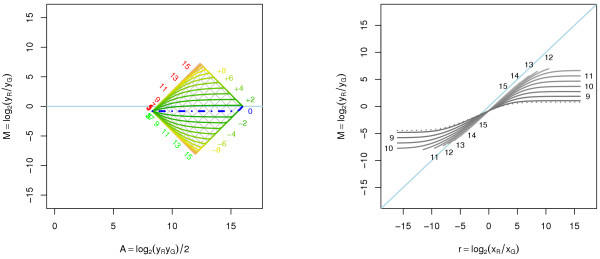
Parallel translation normalization of affine transformed data. Parallel translation normalization of A1
 MathType@MTEF@5@5@+=feaafiart1ev1aaatCvAUfeBSjuyZL2yd9gzLbvyNv2CaerbwvMCKfMBHbqedmvETj2BSbWenfgDOvwBHrxAJfwnHbqeg0uy0HwzTfgDPnwy1aqee0evGueE0jxyaibaieYdOi=BH8vipeYdI8qiW7rqqrFfpeea0xe9Lq=Jc9vqaqpepm0xbbG8FasPYRqj0=yi0lXdbba9pGe9qqFf0dXdHuk9fr=xfr=xfrpiWZqaaeaabiGaaiaacaqabeaadaqacqaaaOqaaGWaaiab=bq8bnaaBaaaleaatCvAUfKttLearCWrP9MDH5MBPbIqV92AaGqbaiab+fdaXaqabaaaaa@43C0@ transformed data. The optimal amount of normalization shift in the raw data is a = 220, which corresponds to an effective shift of (a′G
 MathType@MTEF@5@5@+=feaafiart1ev1aaatCvAUfKttLearuWrP9MDH5MBPbIqV92AaeXatLxBI9gBaebbnrfifHhDYfgasaacH8akY=wiFfYdH8Gipec8Eeeu0xXdbba9frFj0=OqFfea0dXdd9vqai=hGuQ8kuc9pgc9s8qqaq=dirpe0xb9q8qiLsFr0=vr0=vr0dc8meaabaqaciaacaGaaeqabaqabeGadaaakeaacuWGHbqygaqbamaaBaaaleaacqWGhbWraeqaaaaa@2F46@, a′R
 MathType@MTEF@5@5@+=feaafiart1ev1aaatCvAUfKttLearuWrP9MDH5MBPbIqV92AaeXatLxBI9gBaebbnrfifHhDYfgasaacH8akY=wiFfYdH8Gipec8Eeeu0xXdbba9frFj0=OqFfea0dXdd9vqai=hGuQ8kuc9pgc9s8qqaq=dirpe0xb9q8qiLsFr0=vr0=vr0dc8meaabaqaciaacaGaaeqabaqabeGadaaakeaacuWGHbqygaqbamaaBaaaleaacqWGsbGuaeqaaaaa@2F5C@) = (420, 240). Left: Log-ratios as a function of log-intensities for certain fold changes. The r = 1 curve (dot-dash blue) is horizontal, that is, for this specific value of r and a the log-ratios are independent of the log-intensities. Right: Normalized log-ratios versus true log-ratios. From this graph it is clear that we obtain the minimum error in log-ratios at zero-fold change.